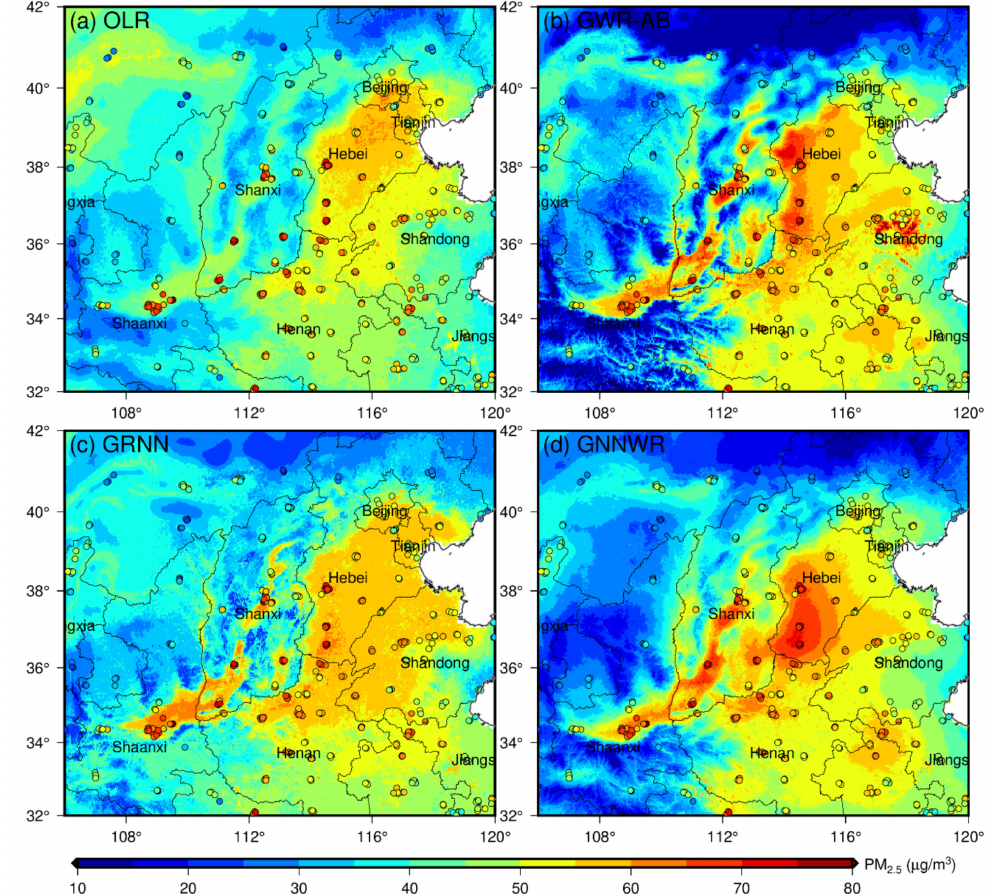
Figure 8. Regional comparison of annual mean satellite-estimated PM 2.5 of different models in the North China